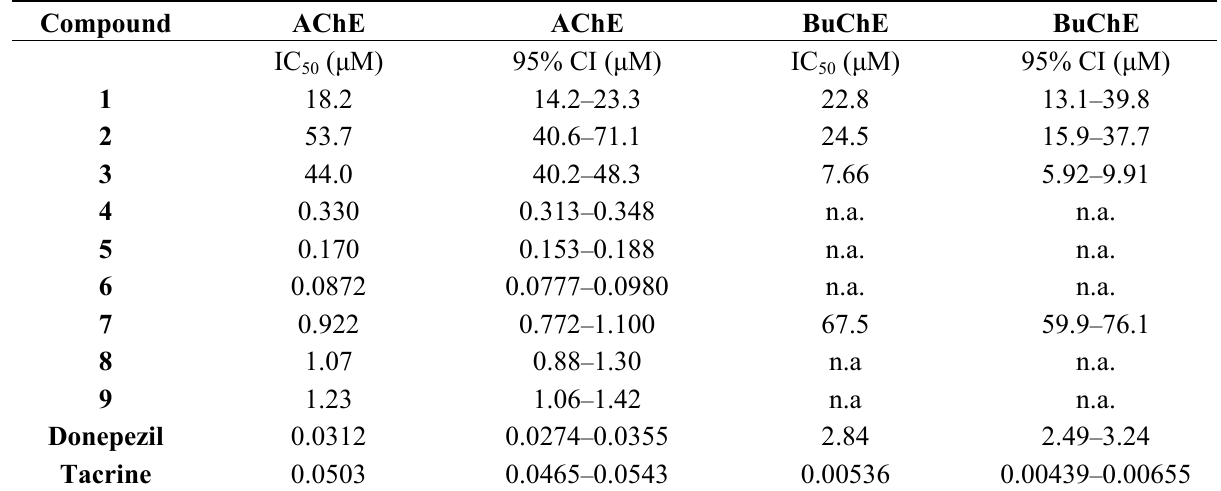
Table 5. Anticholinesterases activity of designed